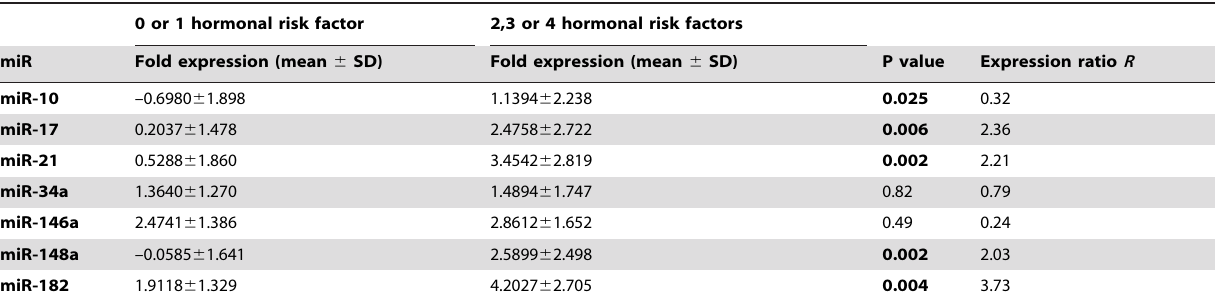
Table 8. Comparison of miRs fold expression levels according to 0 or 1 hormonal risk factor and to the hormonal additive effect (age of first menstruation, age at the first pregnancy, use of the contraceptive pills and breastfeeding) among triple negative breast